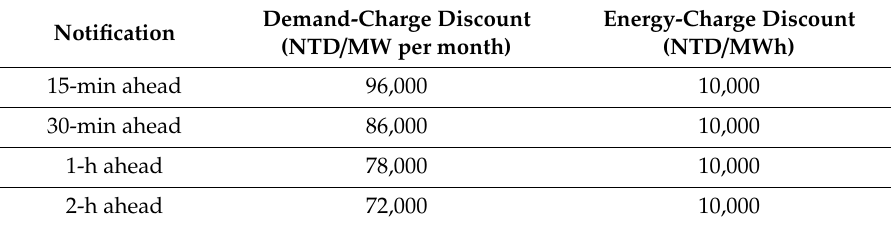
Table 4. The rate discount provided by the Taiwan Power Company EDRP